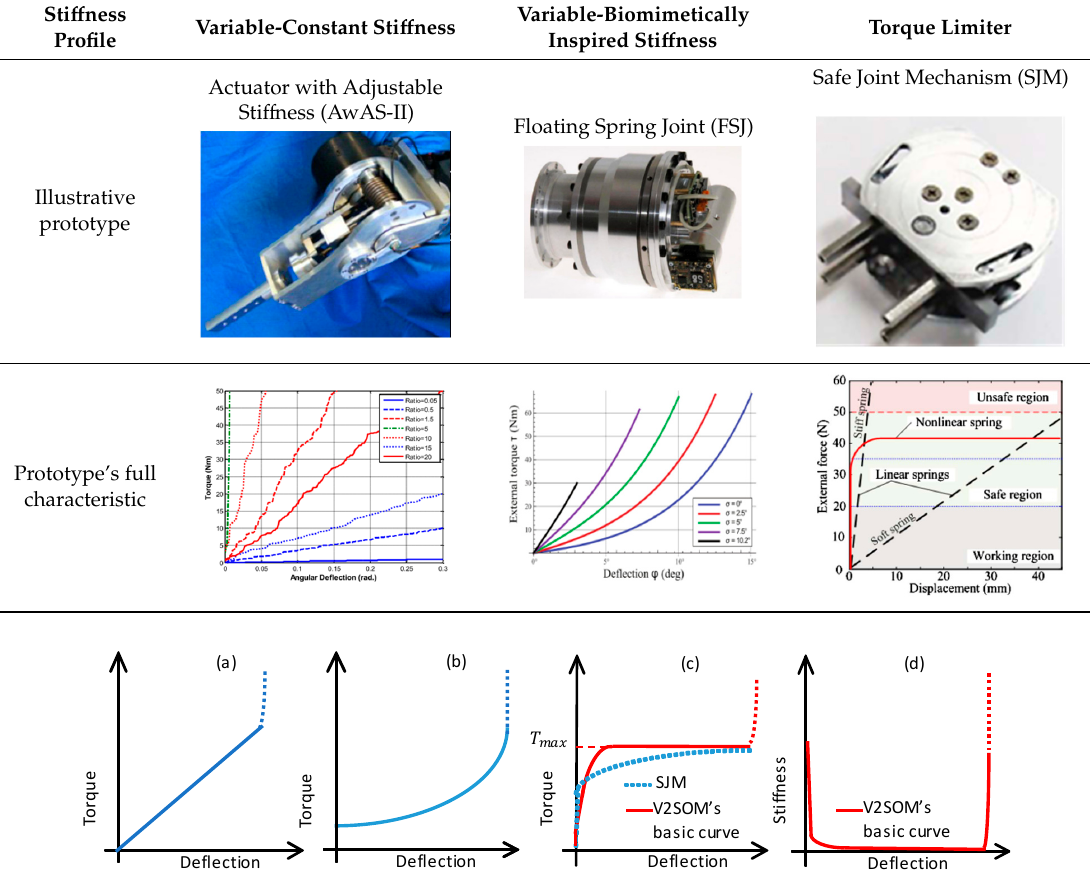
Table 1. The three main categories of VSAs according to their stiffness characteristic.